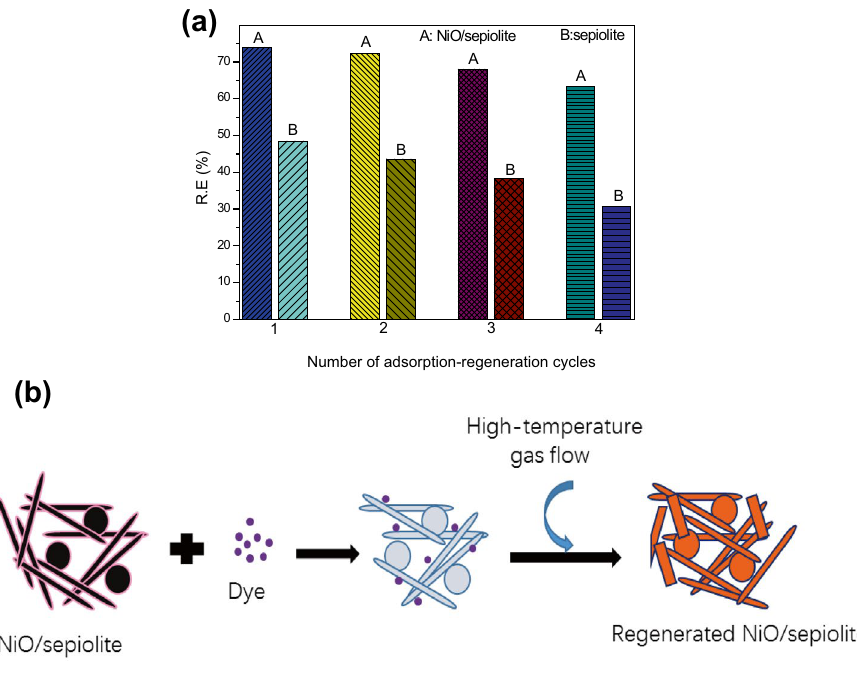
Figure 7. Regeneration rate over four cycles of adsorption and regeneration for removal of dye from aqueous solution using NiO/sepiolite and sepiolite ( a ), Schematic diagram of the adsorption and high-temperature gas flow regeneration process on NiO/sepiolite ( b